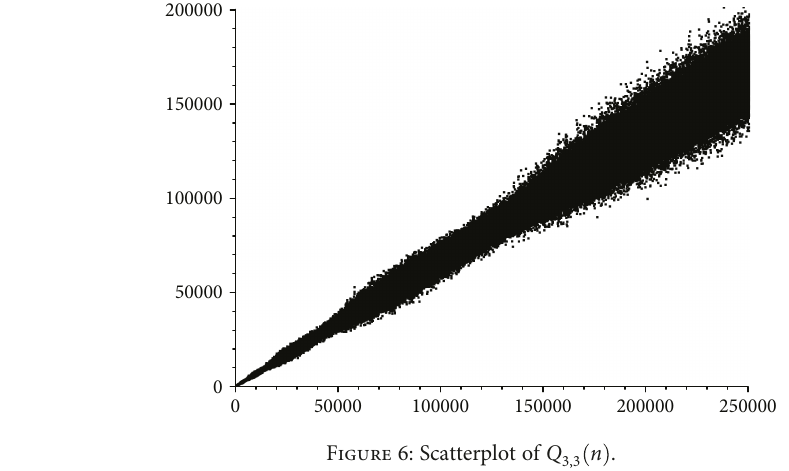
Figure 6: Scatterplot of Q